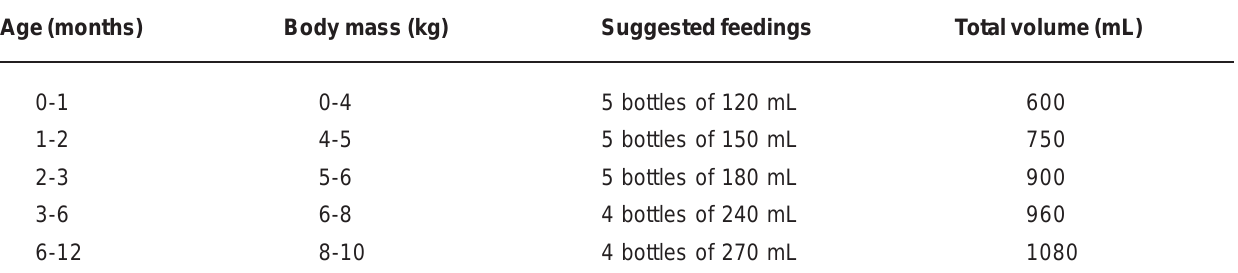
* Data from Mead Johnson, Crows Nest,